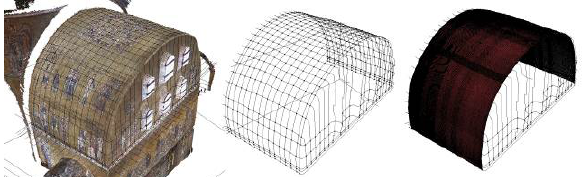
Figure 2: Vault modelling from slices extraction from point cloud (left), network of curves (centre), 3D surface (right) A very similar approach was used to build vaults and domes (Figure 2). The curves, in both longitudinal and transverse directions, were extracted by the point cloud to create a virtual network of slices, where each knot must belong to both direction sections. Also in this way, quite far from the automation, the distance between subsequent slices must be set according to the deformation and complexity of the vault. interact with the structure (such as capitals and statues) have point clouds. Even if the dimensions in terms of memory obtained from the survey.